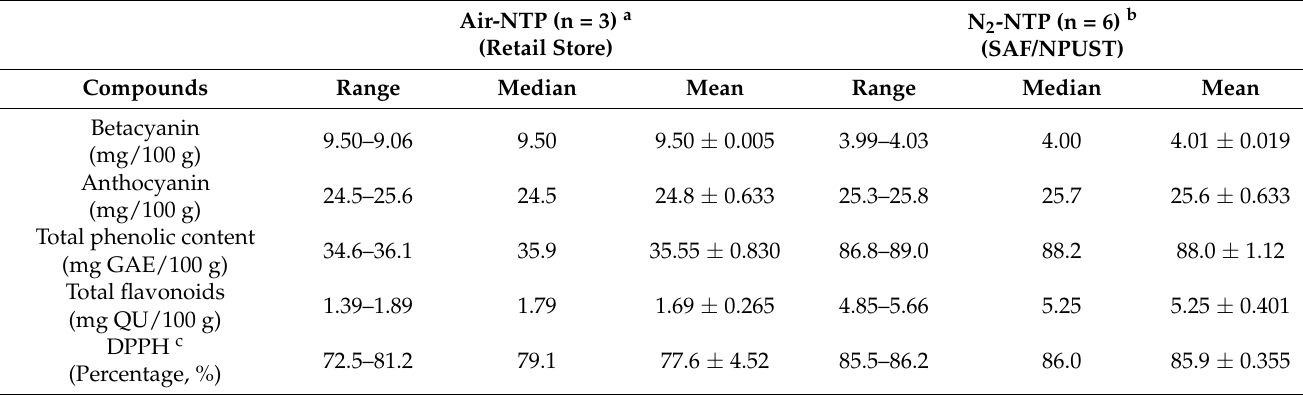
Table 2. Levels of natural bioactive compounds in the djulis seed without the NTP